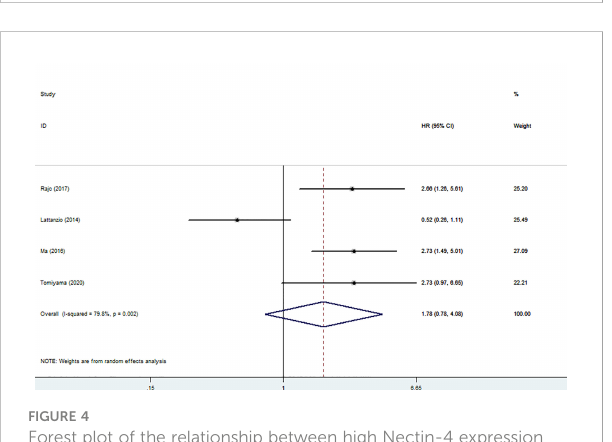
FIGURE 4 Forest plot of the relationship between high Nectin-4 expression and DFS/PFS/RFS.